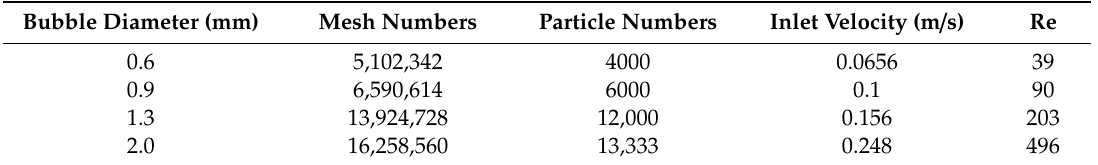
Table 2. The mesh numbers, particle numbers, fluid velocities, and Reynolds number corresponding to the bubble diameter.